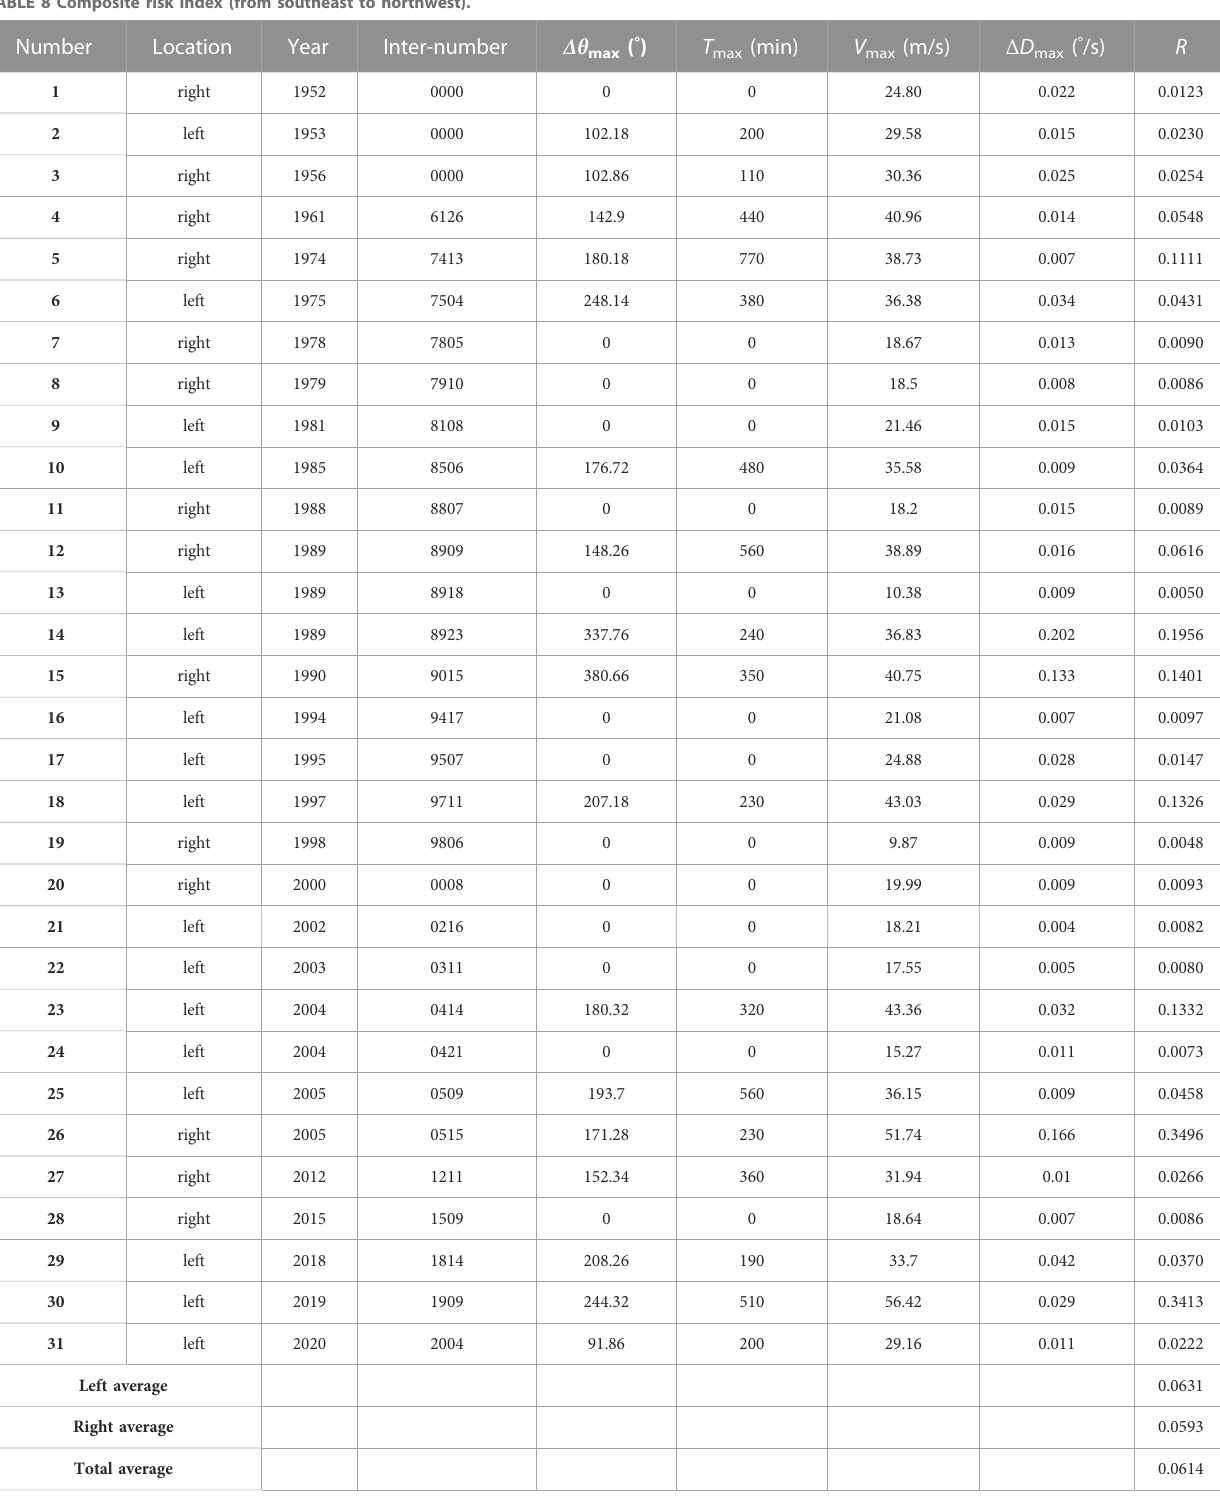
TABLE 8 Composite risk index (from southeast to